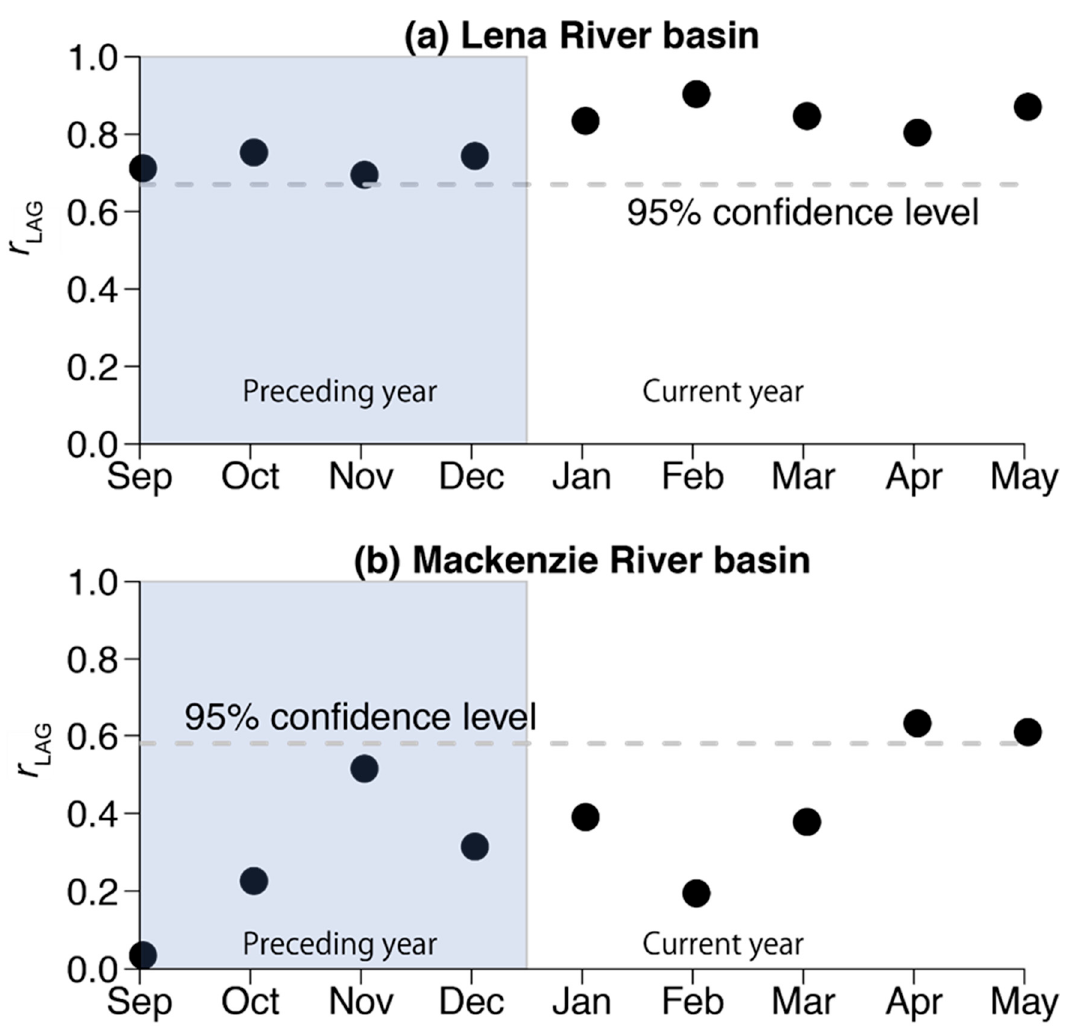
Figure 9. Seasonal variations in the monthly correlation coefficients r LAG for different time-lagged values of the TWS. Dashed gray lines indicate the 95% confidence level. Shaded areas denote the preceding year in comparison with the river runoff of the current year. Lena River basin ( a ) and Mackenzie River basin ( b ).